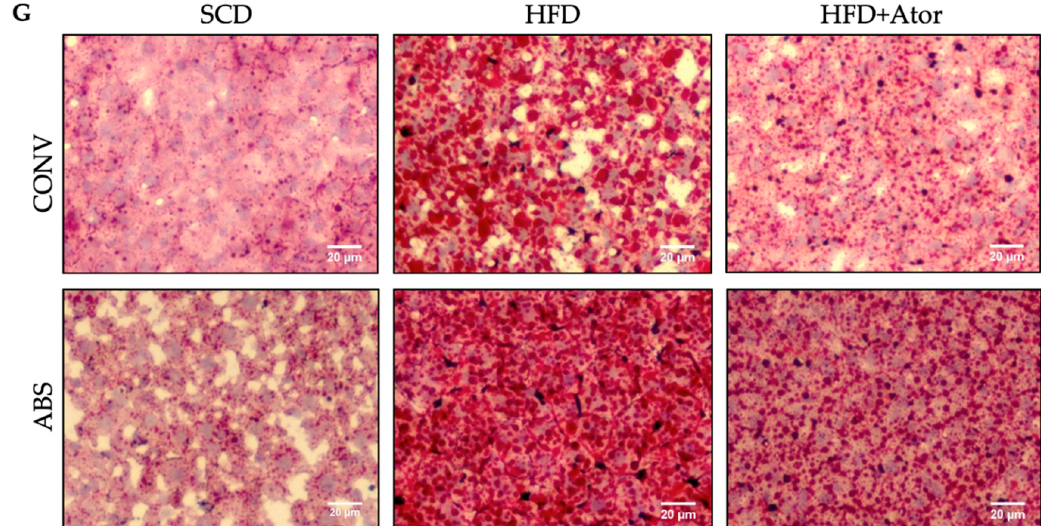
Figure 3. Analysis of plasma lipids. ( A – D ): Alterations of blood lipids in CONV ( n = 14) and ABS ( n = 13) mice under SCD or HFD and atorvastatin (Ator). ( E , F ): Representative HPLC plots of CONV ( E ) and ABS mice ( F , G ): Representative liver sections stained with hematoxylin-eosin and oil red o. Error bars indicate SEM. * = p < 0.05; ** = p < 0.01.